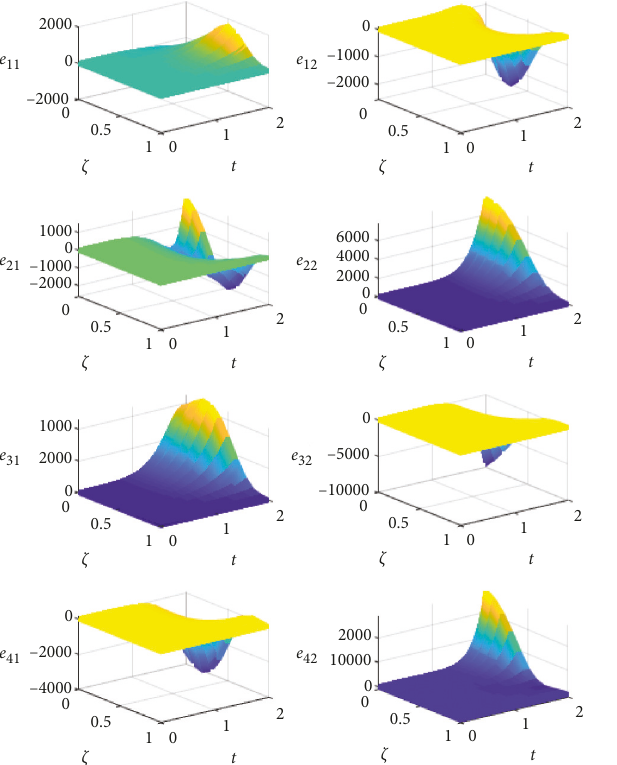
ζ , t . Figure 5: The closed-loop profile of z ( )